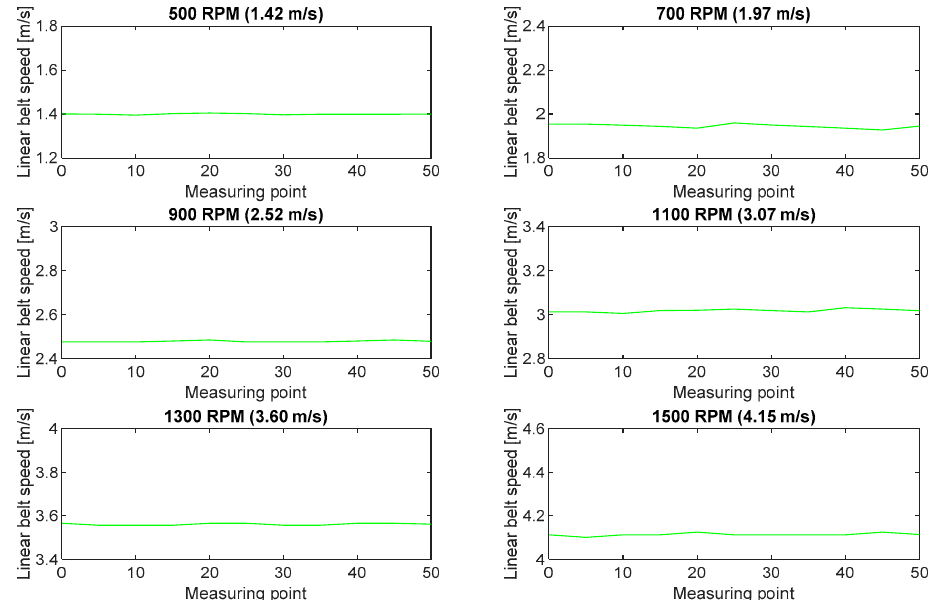
Figure 12. Fluctuations of belt linear speeds calculated in the measurements with the use of the high-speed camera for six rpm ranges of the pulley motor.